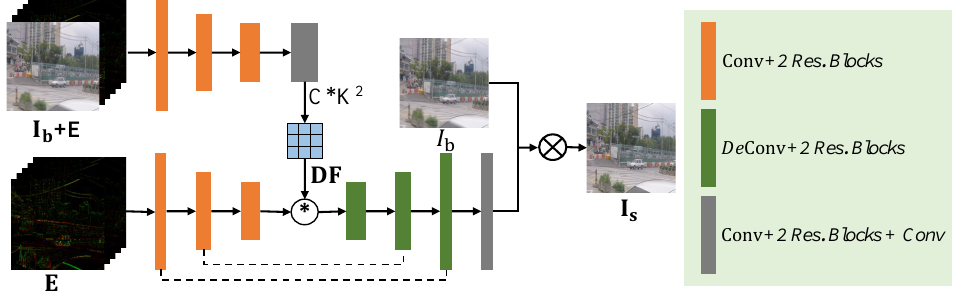
Figure A1. Framework of